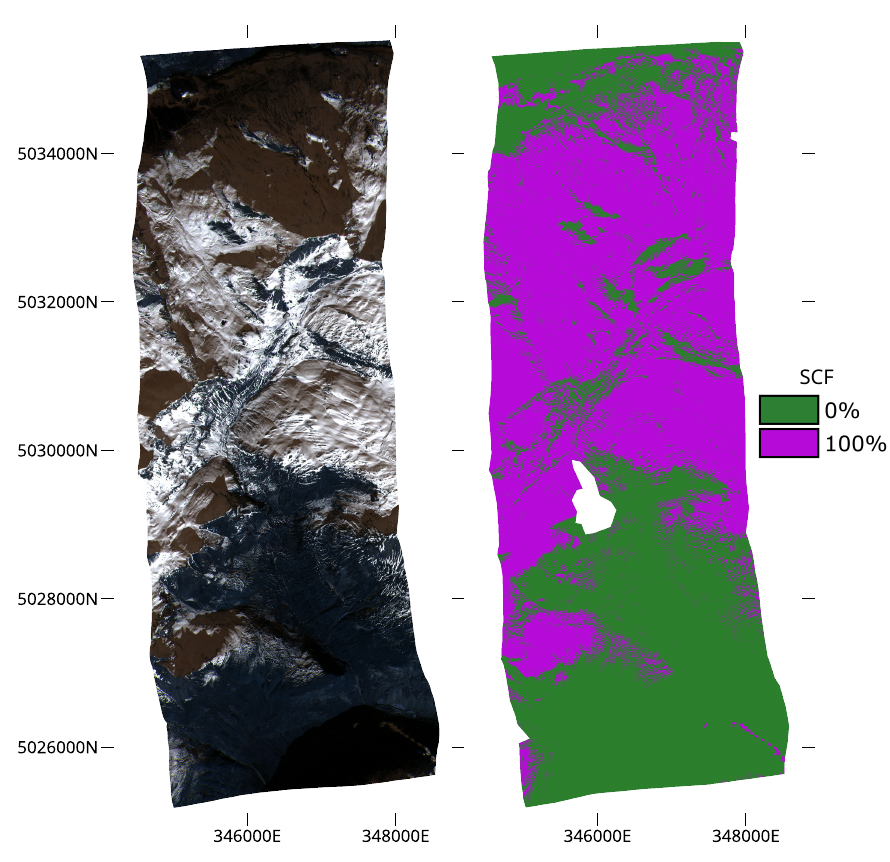
Figure A5. ( Left ): WorldView-3 true colour composite taken on 22 November 2020 (reference № 5 in Table A2). ( Right ): Binary snow classification of the left-side